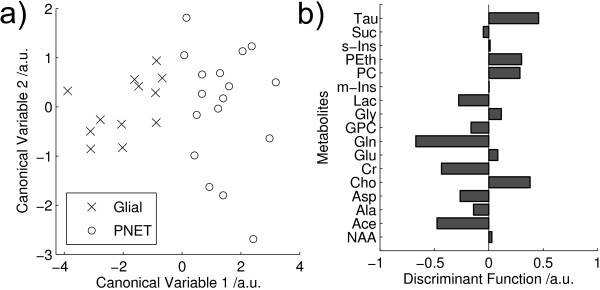
LDA PNET vs glial. Linear discriminant analysis of PNET vs glial tumours performed on the first 3 principal components of fitted metabolite quantities showing a) Discriminant Function (DF) scores and b) coefficients of the first DF. Tau – Taurine, Suc – Succinate, s-Ins – scyllo inositol, PEth – phosphorylethanolamine, PC – phosphorylcholine, m-Ins – myo-inositol, Lac – lactate, Gly – glycine, GPC – glycerophosphorylcholine, Gln – glutamine, Glu – glutamate, Cr – creatine, Cho – choline, Asp – aspartate, Ala – alanine, Ace – aspartate, NAA – N-acetylaspartate. (classifier accuracy: 90%).